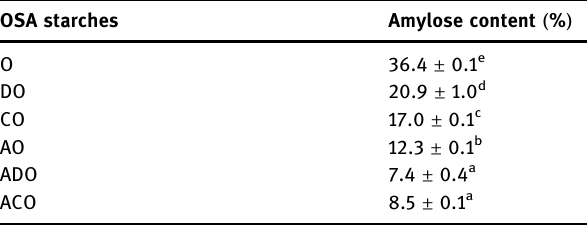
Table 5: Amylose contents of OSA starches OSA starches